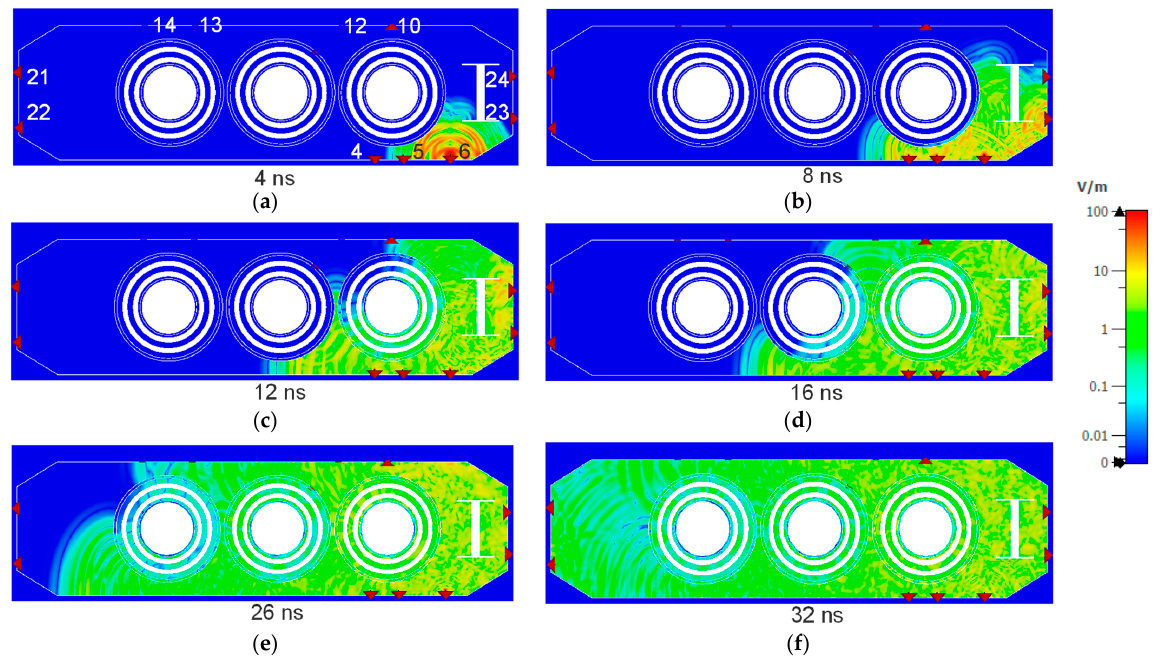
Figure 14. Electromagnetic wave propagation at different times when the PD source is at position 6 (transformer A): ( a ) at 4 ns; ( b ) at 8 ns; ( c ) at 12 ns; ( d ) at 16 ns; ( e ) at 26 ns; ( f ) at 32 ns.